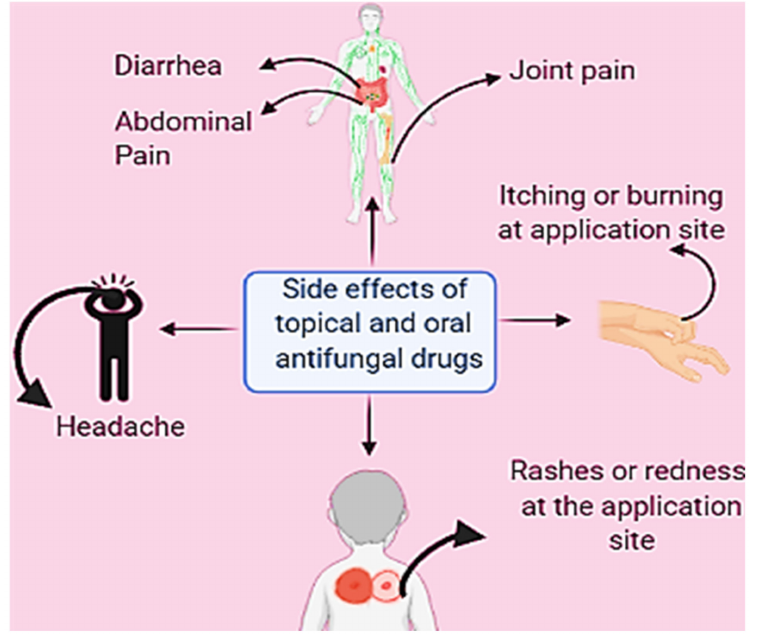
Figure 1. Side effects of synthetic antifungal drugs. These side effects are due to uncontrolled drug release and can lead to prolonged treatment due to low penetration; consequently, these drugs may not reach the target location and could lead to the incomplete clearance of infection.